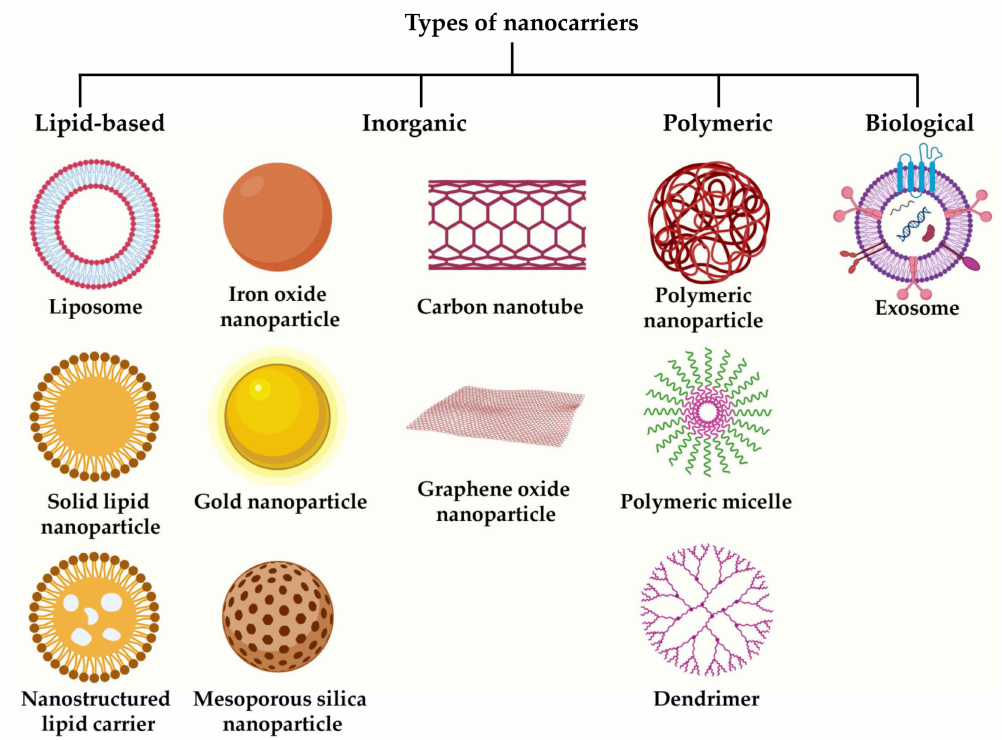
Figure 2. Types of nanocarriers frequently used for cancer therapy. Created with